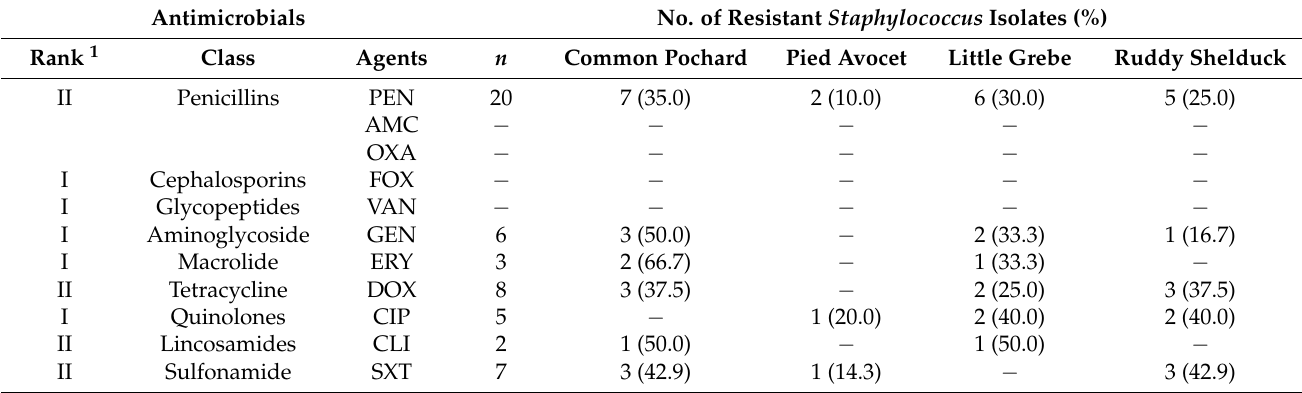
Table 3. The antimicrobial-resistant profile of Staphylococcus ( n = 37) isolates recovered from migratory wild birds around the Al-Asfar Lake.